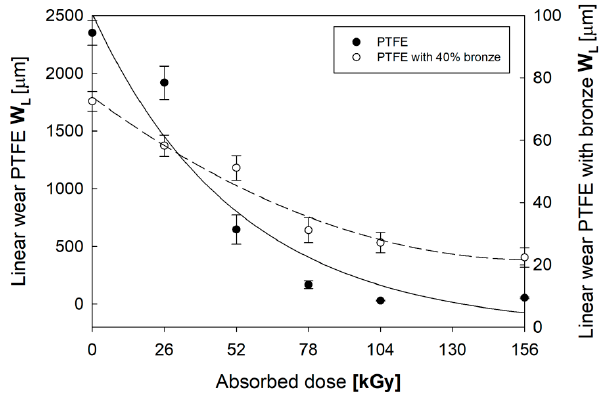
Figure 9. Changes in the linear wear of W L of PTFE and PTFE with 40% bronze as a function of the absorbed radiation dose.